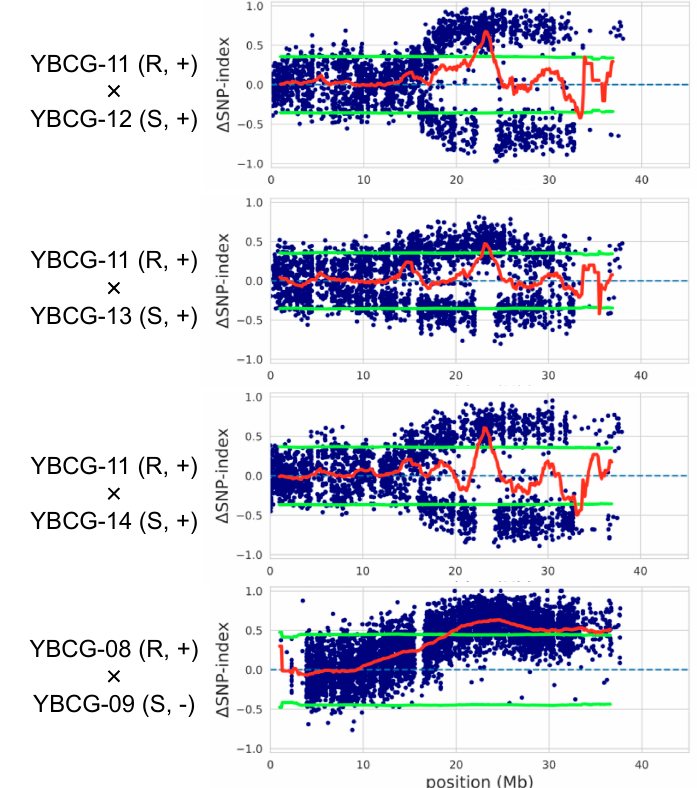
Figure 1. QTL-seq results on chromosome A03. F 2 populations derived from YBCG-11 × YBCG-12, dots indicate ∆ SNP-index, and the red line indicates the sliding window average of ∆ SNP-index. Light green lines represent p < 0.05. R and S represent resistant and susceptible, respectively. + and - represent the presence and absence of PCR amplification of Bra012688m marker, respectively. Because FocBr1 was included in three QTLs, we focused on FocBr1 for further analysis. The expression level of FocBr1 in three susceptible lines (“Zaoh”, YBCG-12, and YBCG- 15) was similar to that of resistant lines (YBCG-11 and YBCG-16) (Figure 2), indicating that expression levels are not related to susceptibility. Next, we compared the amino acid sequences of FocBr1 in resistant and susceptible lines. The amino acid sequence of FocBr1 in the resistant line, YBCG-11, was 100% identical to FocBr1 in the resistant line, RJKB-T23 [12]. Amino acid sequences of FocBr1 were 100% identical among bulked DNAs of susceptible plants derived from F 2 populations of YBCG-11 × YBCG-12, YBCG-11 × YBCG-13 and YBCG-11 × YBCG-14 hybrids, but there were some substitutions of amino acid